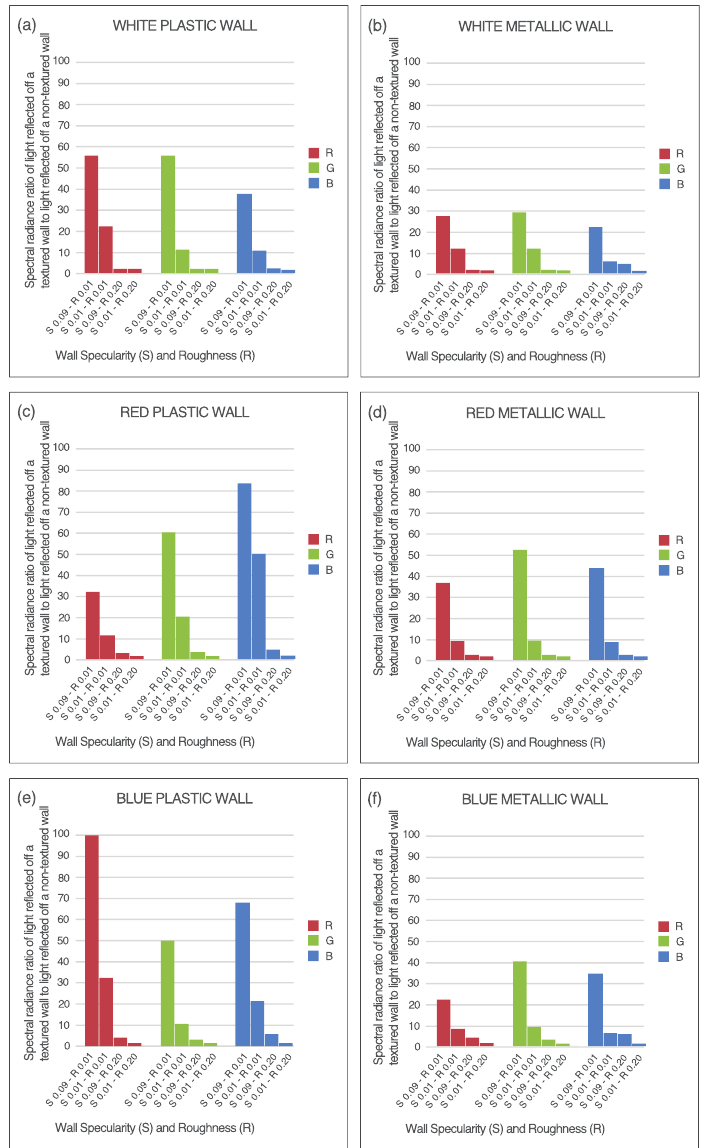
Figure 9. Comparison of spectral radiance ratios of light reflected off an active textured wall to light reflected of a non-textured active wall for different materials for those cases with extreme specularity and roughness values.